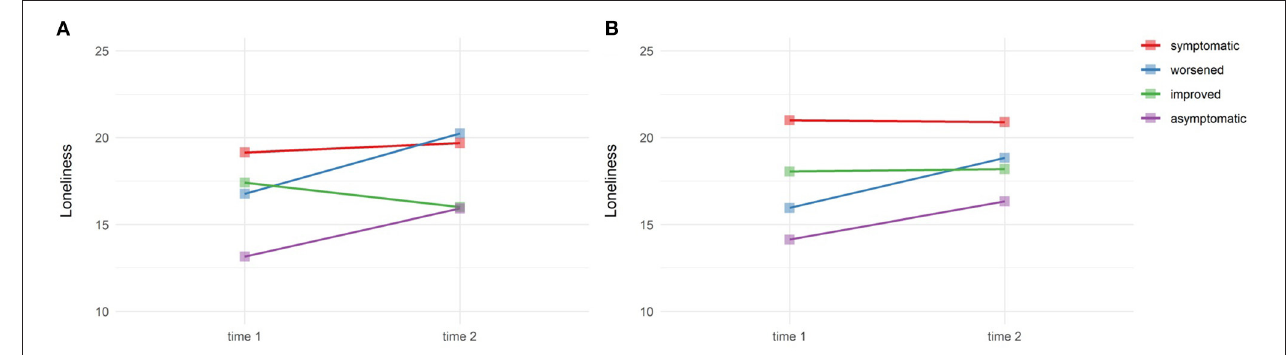
FIGURE 1 | Feelings of loneliness and trajectories of depressive symptoms (A) and anxiety symptoms (B) during the COVID-19